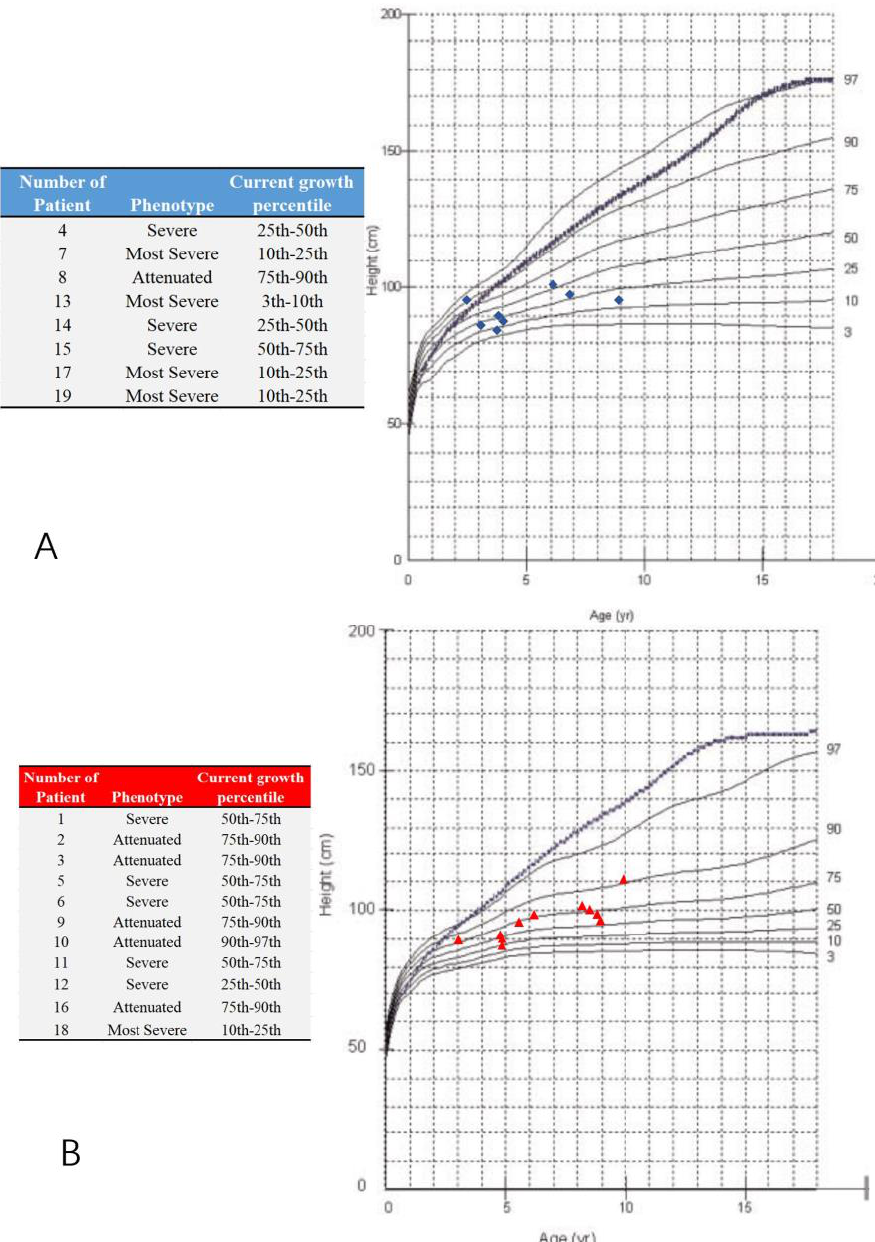
Figure 3. Growth charts of males and females with mucopolysaccharidosis IVA and study participants. ( A ) The blue ‘ ◆ ’ shows male participants; ( B ) the red ‘ ▲ ’ shows female participants; Note: the dotted and blue lines show the 50th percentile values for normal males and females; revised from Montaño et al. [26]. The phenotype is defined by the present height; less than 25th percentile (the most severe), the 25th–75th percentile (severe), over 75th percentile (attenuated). Table 2. Age-matched comparison of parameters in MPS IVA hips with the normal cohort.